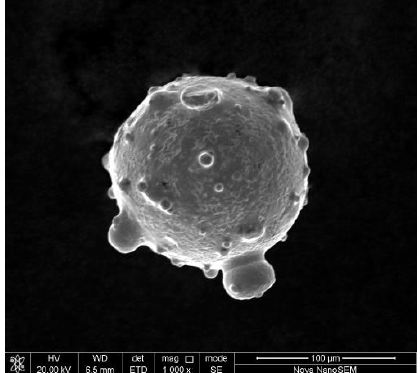
0.5 high entropy alloys (HEA) powder. Materials 2020 , 13 , x FOR PEER REVIEW